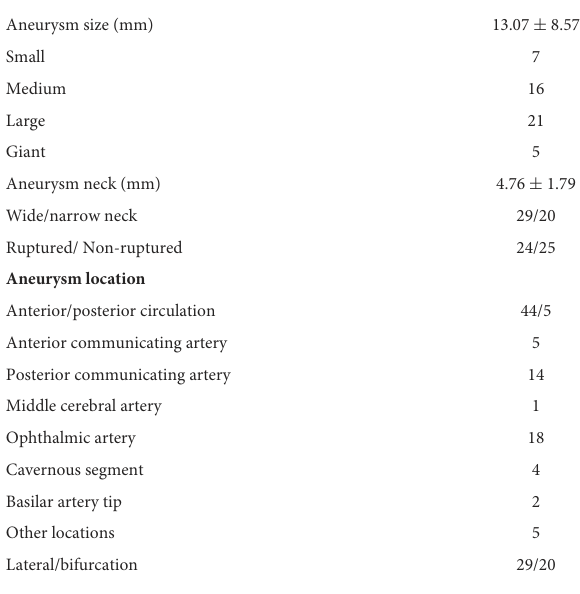
TABLE 2 Baseline data of 49